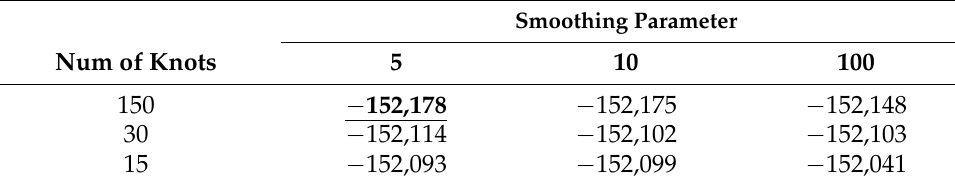
Table 4. DIC for Weibull distribution (23 June 2016, TMC, Aichi, Japan).